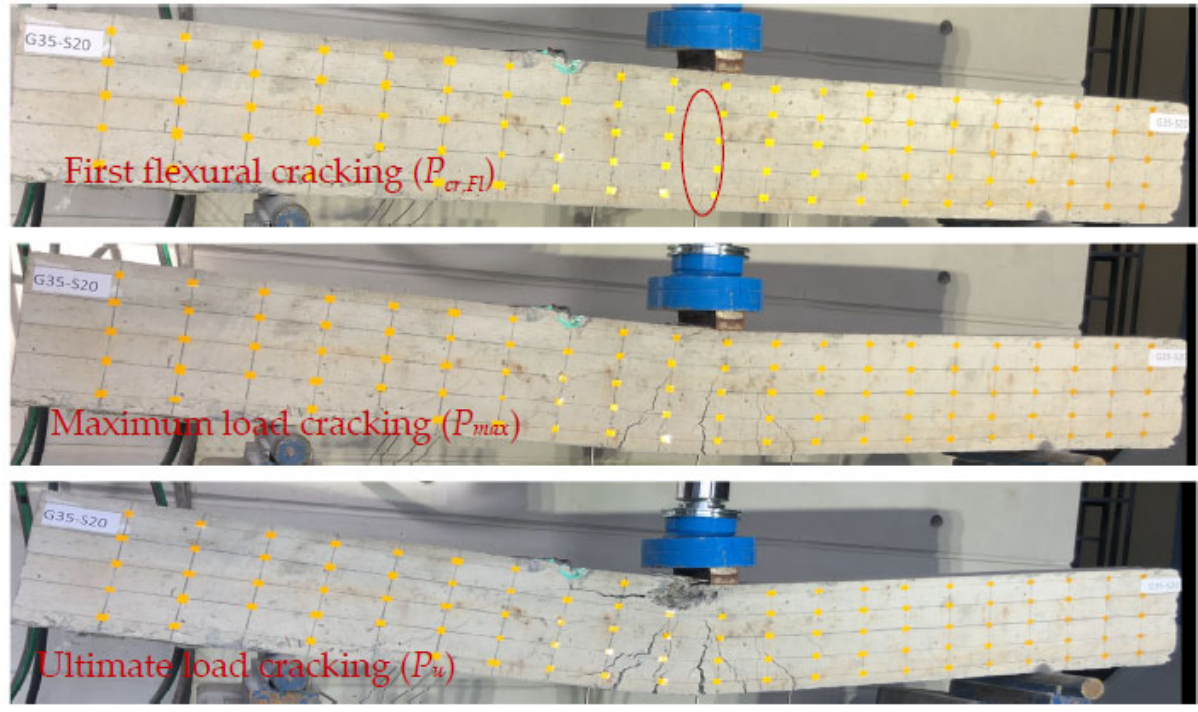
Figure 5. P cr , P max and P u stages for G35S20.